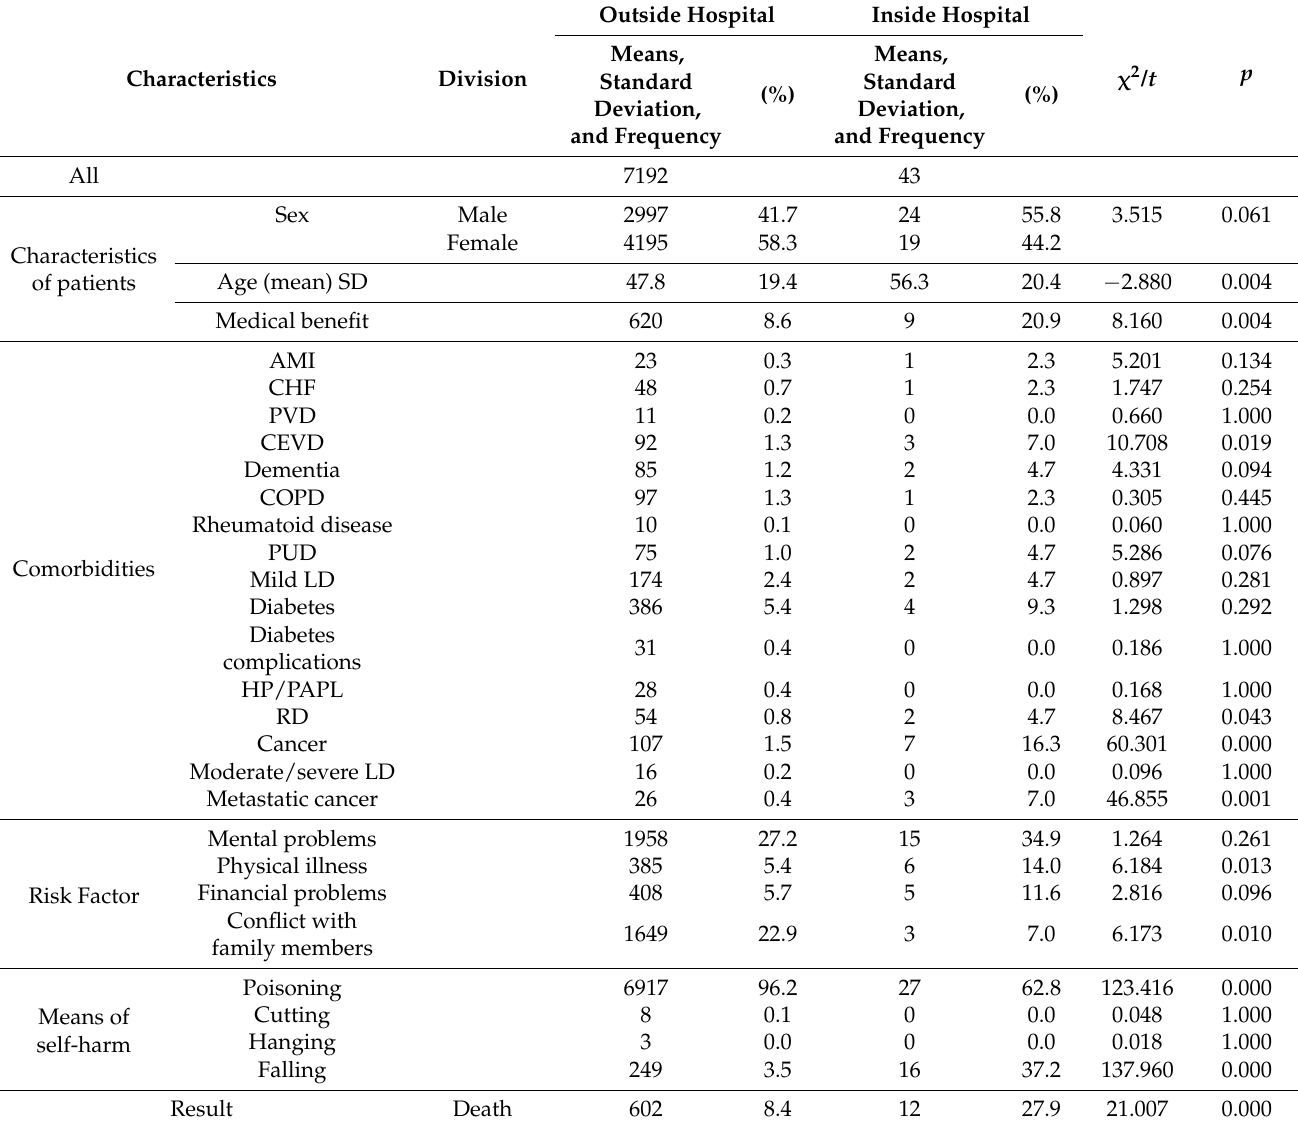
Table 1. Participants’ characteristics by the place where patients performed